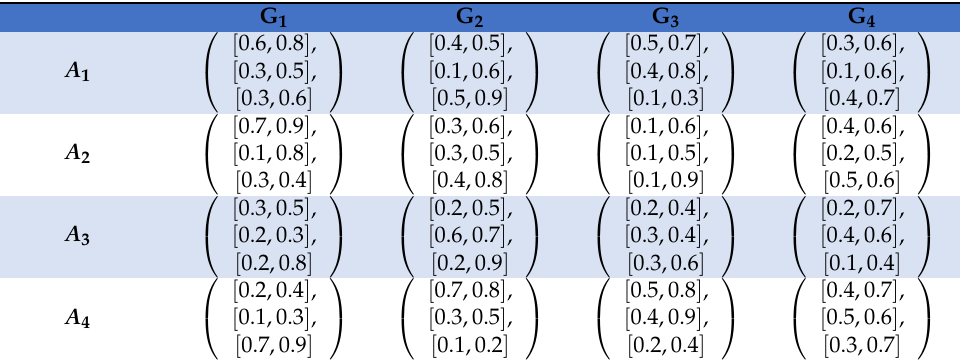
Table 1. Decision matrix.